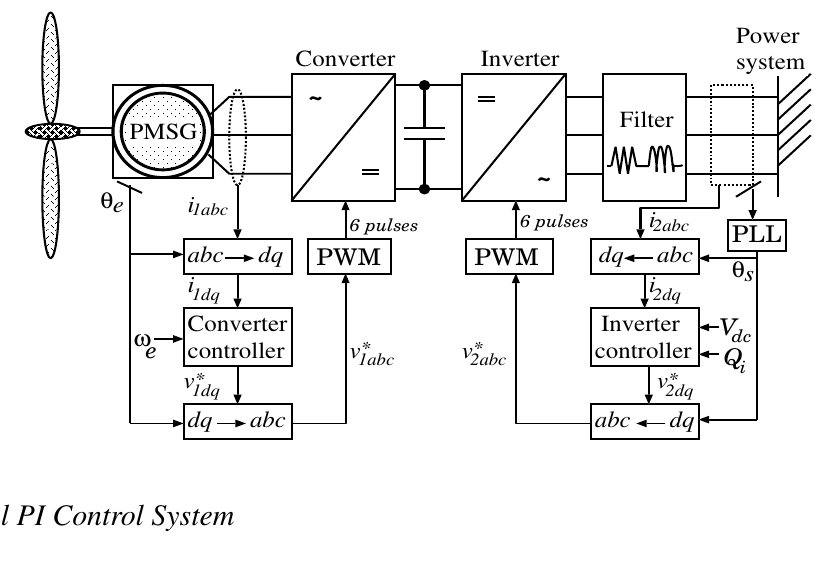
Figure 5. Power converter control